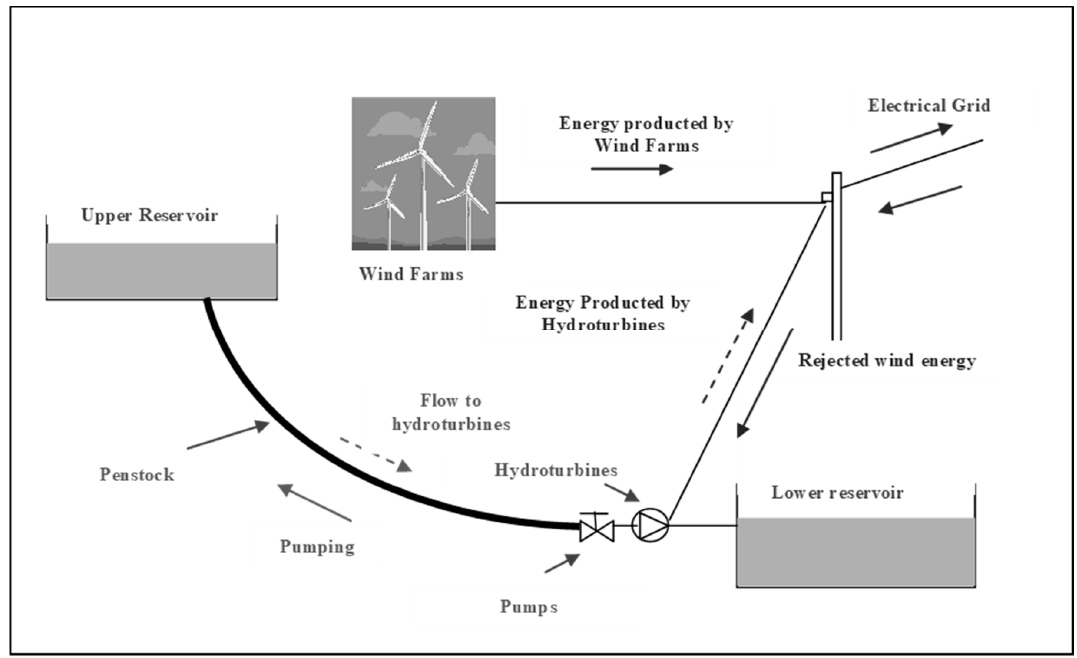
Figure 1. The parts of the proposed Pumped Storage System which absorbs the total daily rejected wind produced electricity.